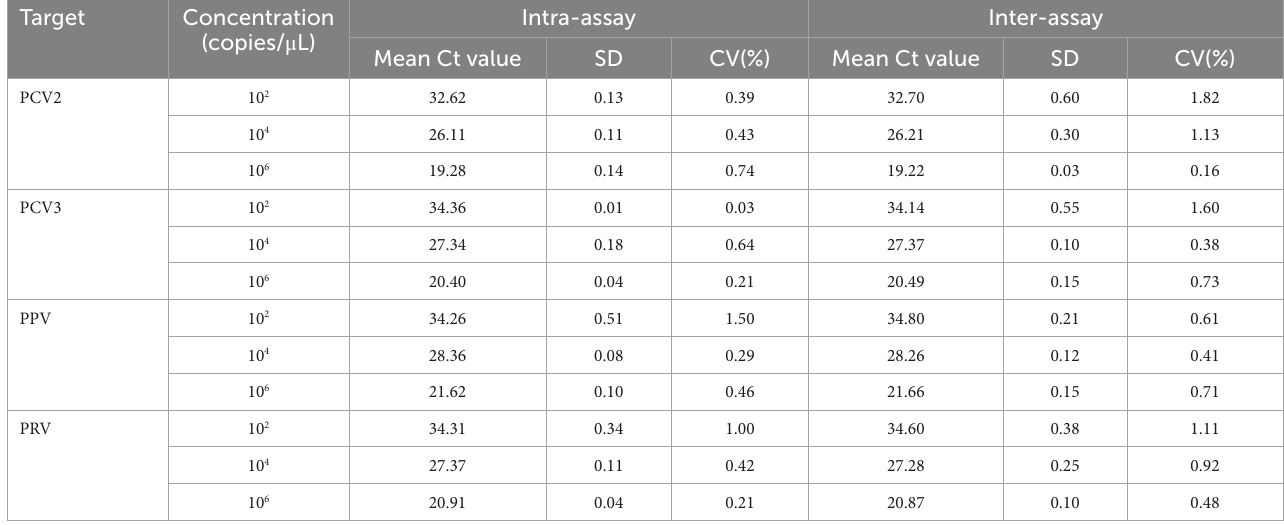
TABLE 2 Repeatability and reproducibility evaluation of the multiplex real-time PCR. Target